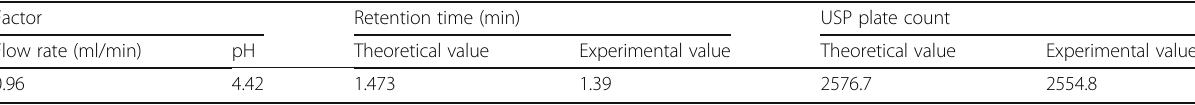
Table 4 Comparison of theoretical values and experimental values on retention time and USP plate count